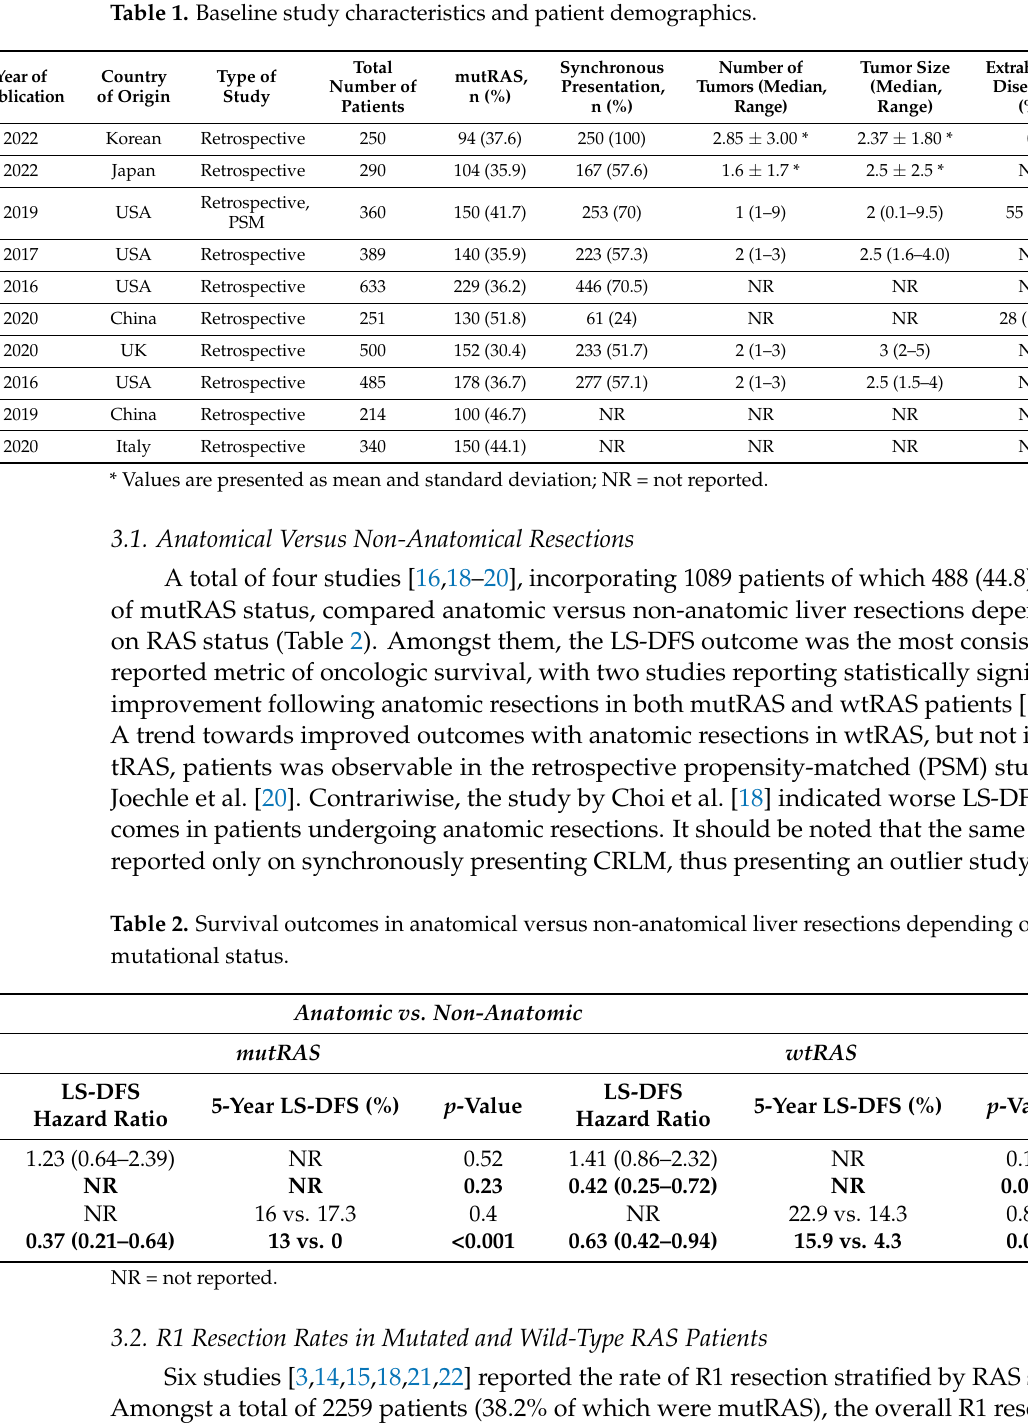
Table 1. Baseline study characteristics and patient demographics.